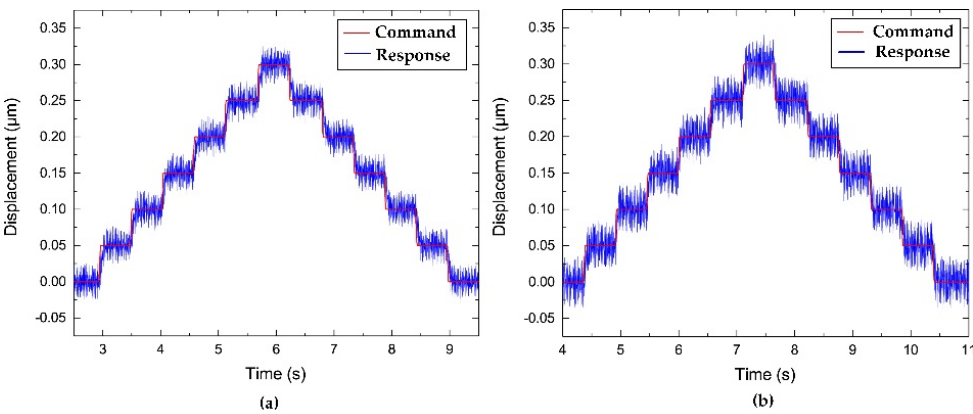
Figure 18. Resolutions of the mechanism along ( a ) z-axis and ( b ) x-axis.